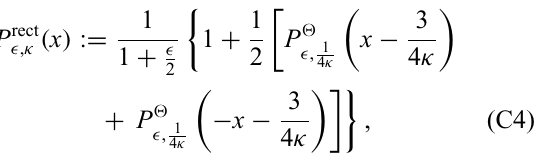
FIG. 19. A sketch of (a) P 1 for κ = 2.5. The resulting polynomial, P MI (cid:14) approximation to the inverse